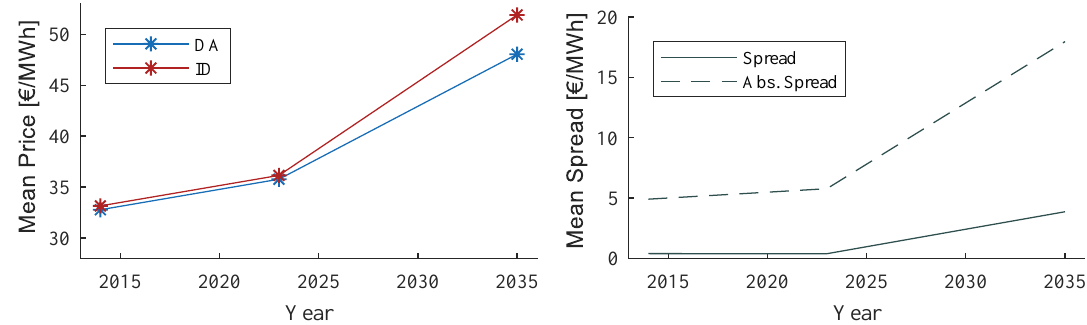
Figure 12. Mean Price on DA and ID ( left ) and mean (absolute) ID-DA Spread ( right ) in 2014 (empiric) and 2023/2035 (model).